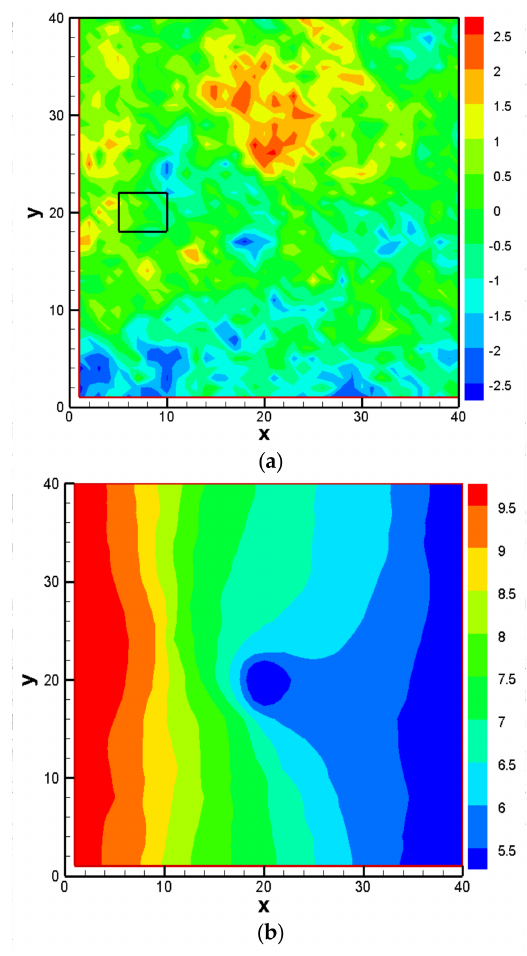
Figure 3. Reference log hydraulic conductivity field and hydraulic head field distribution: ( a ) the reference log hydraulic conductivity field; ( b ) the reference hydraulic head field at the 20th time step. The black rectangle represents the location of the recharge window.